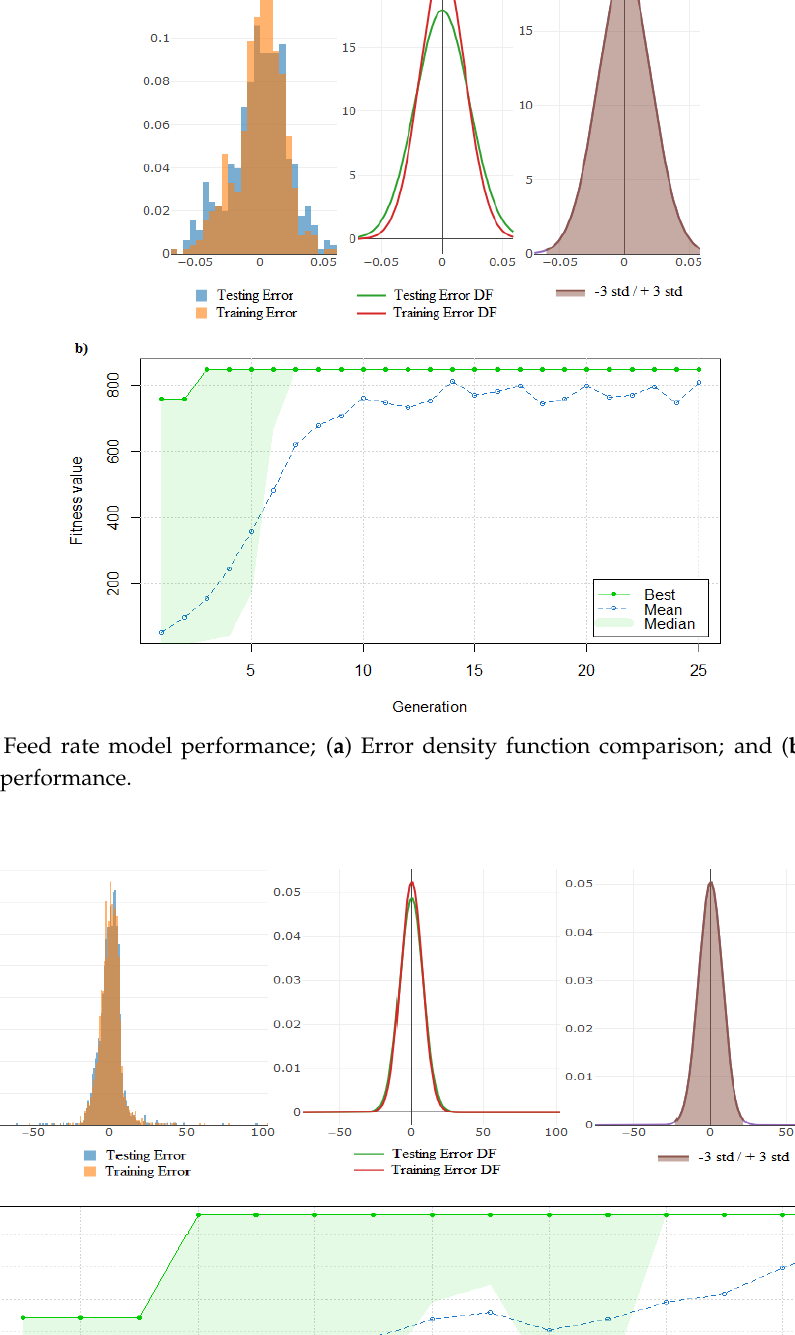
Figure 5. Cutting velocity model performance; ( a ) Error density function comparison; ( b ) Genetic algorithm